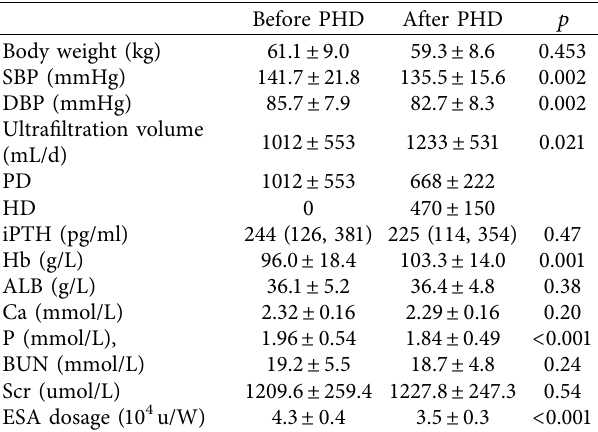
Table 2: Comparison of clinical and laboratory parameters before and after PHD.